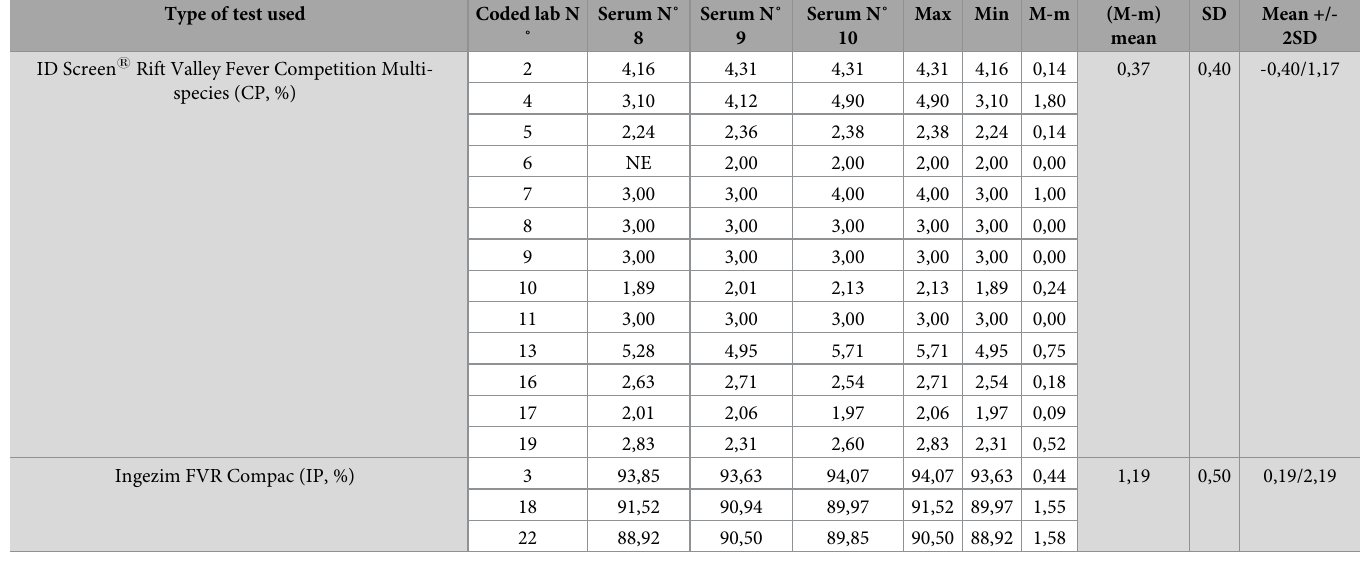
Table 3. Repeatability assessed with either the ID Screen 1 Rift Valley Fever Competition Multi-species or the INgezim FVR Compac kits, based on the 3 sera included in the panel specifically for that purpose. Type of test